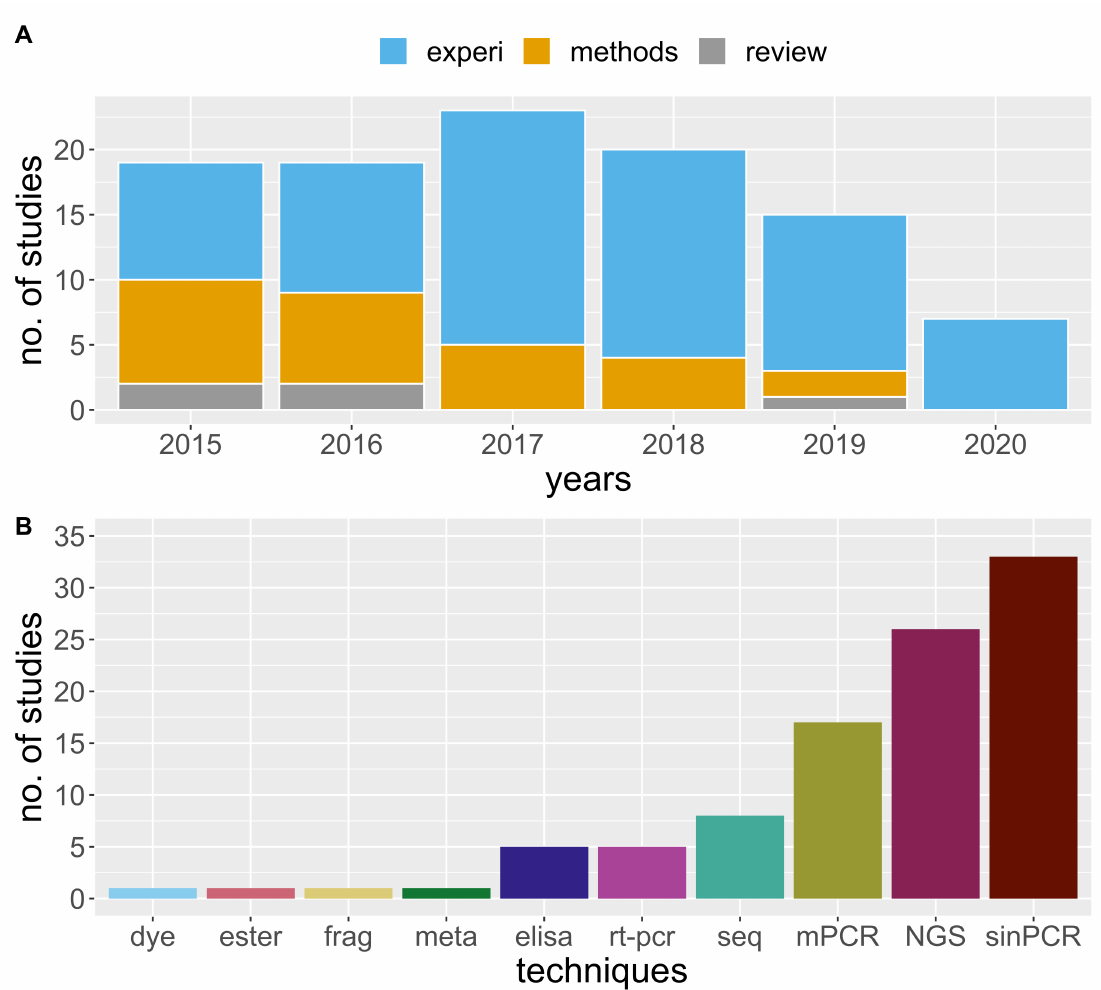
Figure 1. Distribution of molecular trophic interaction studies between 2015 and June 2020 by study type: “experi” for experimental, “methods” for development of new primers or optimization, and “review” for articles that reviewed molecular topics ( A ), and by the technique used to identify interaction ( B ). The technique codes are: fluorescent dye for animals marked with dye, ester for esterase, fragment analysis for frag, meta for metabaroding, elisa for Enzyme-Linked Immunosorbent Assay, rt-pcr for real time or quantitative pcr, seq for sanger sequencing, mPCR for multiplex PCR, NGS for next generation sequencing, and sinPCR for singleplex